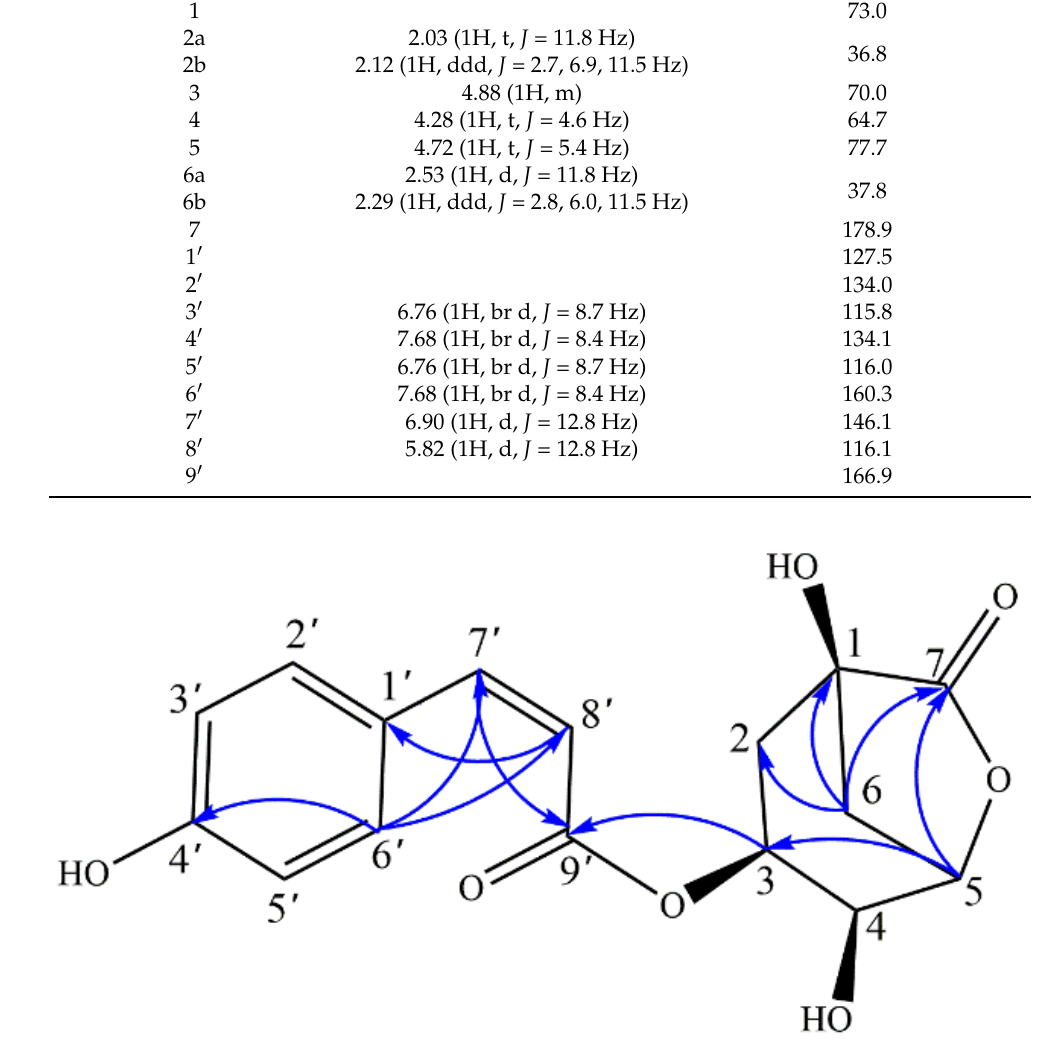
Figure 1. Key HMBC correlations of compound 8. Table 1. 1 H and 13 C-NMR spectroscopic data of compound 8